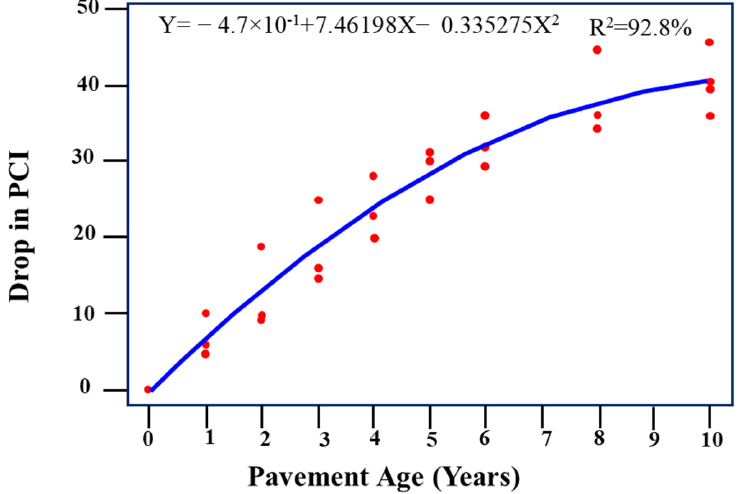
Figure 7. Effect of routine maintenance on the deterioration of PCI for low traffic.